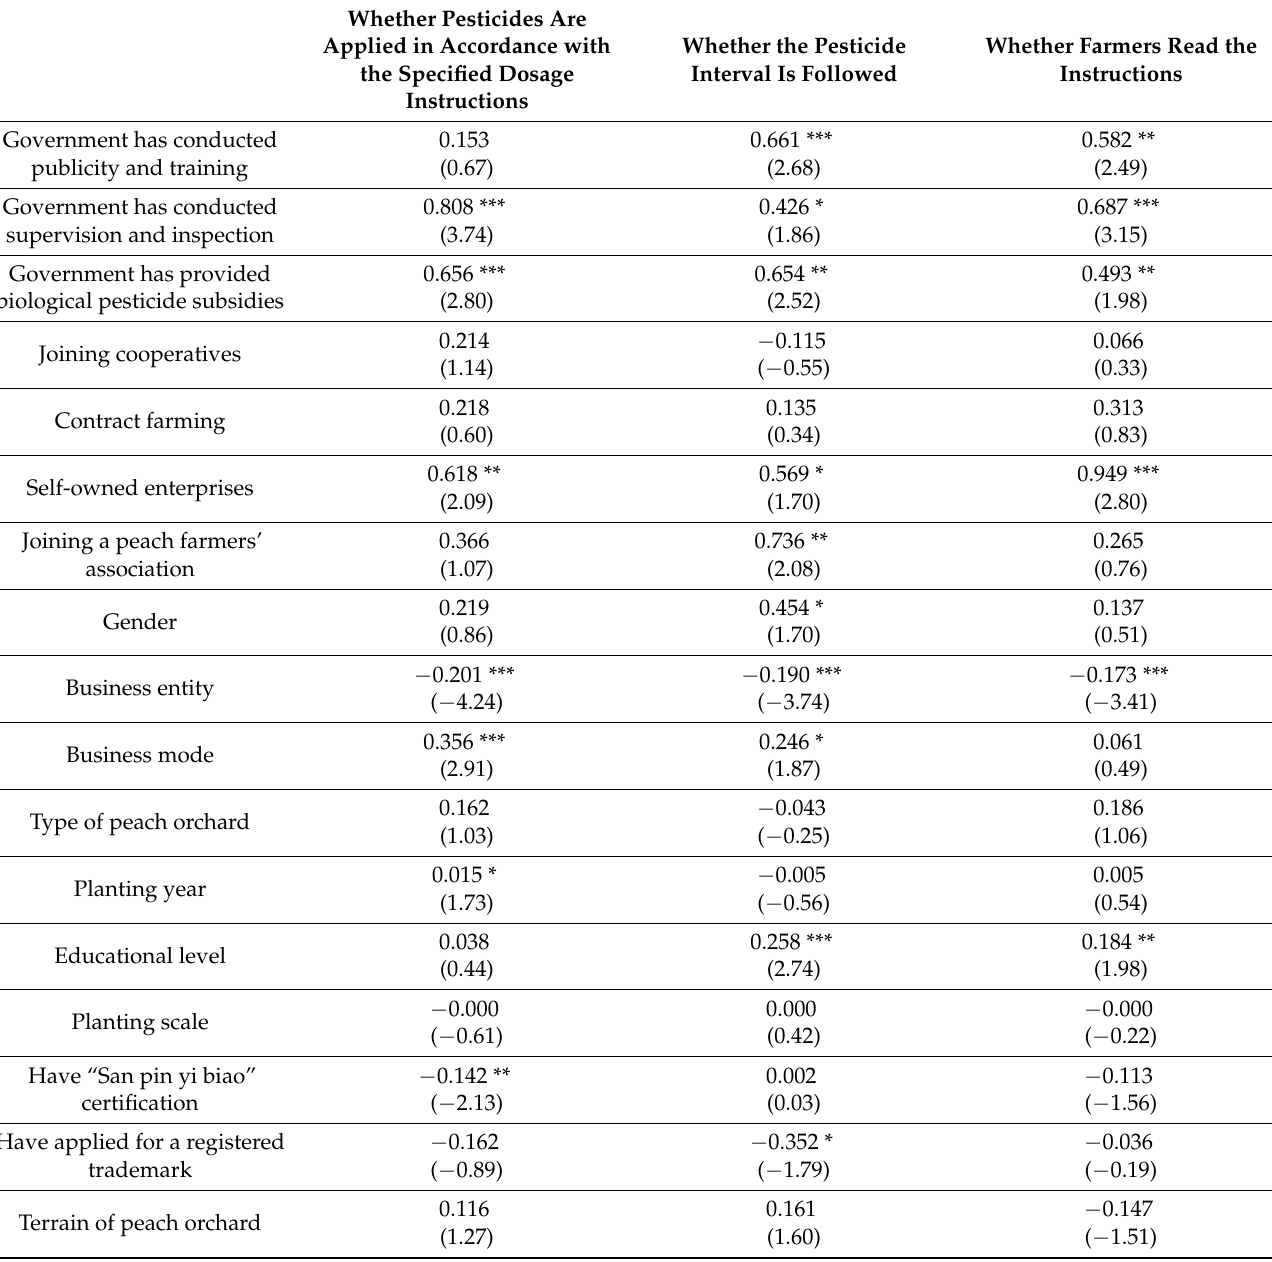
Table 8. Robustness